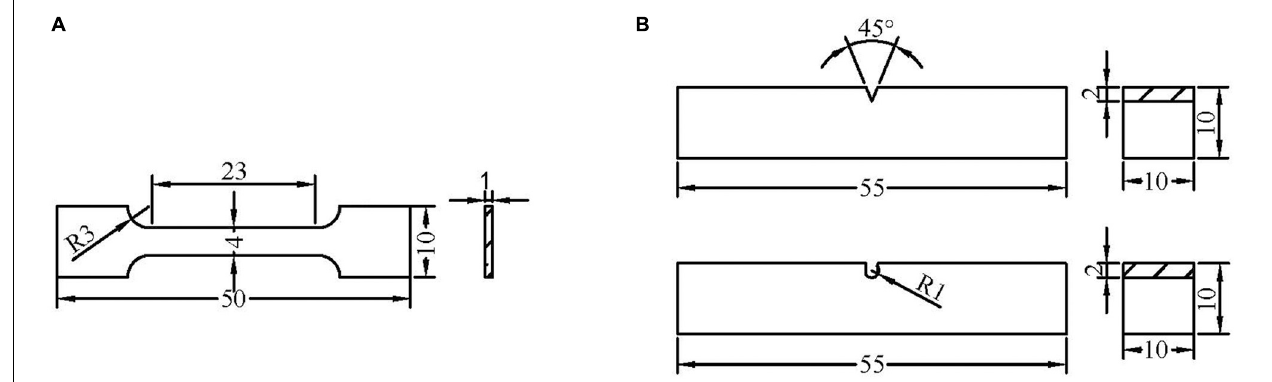
FIGURE 1 | Schematics of the samples for (A) tensile tests and (B) impact